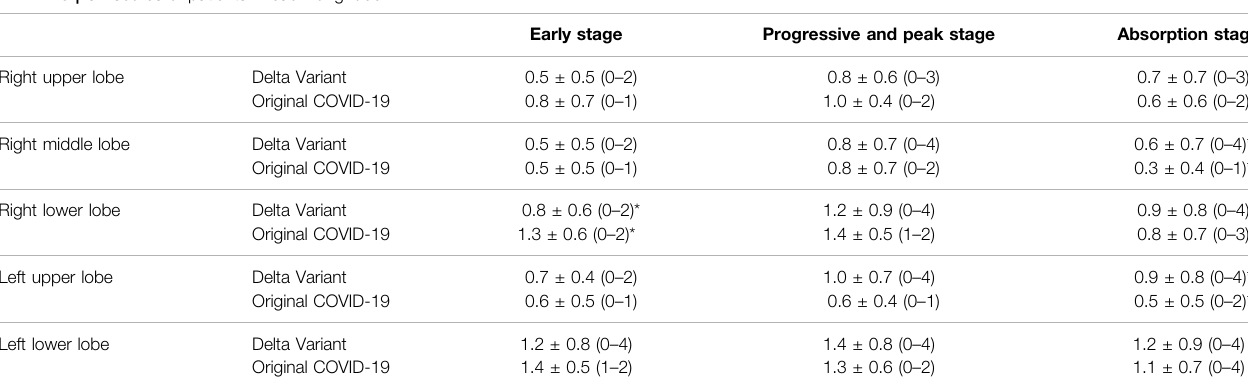
TABLE 3 | CT scores of patients in each lung lobe.